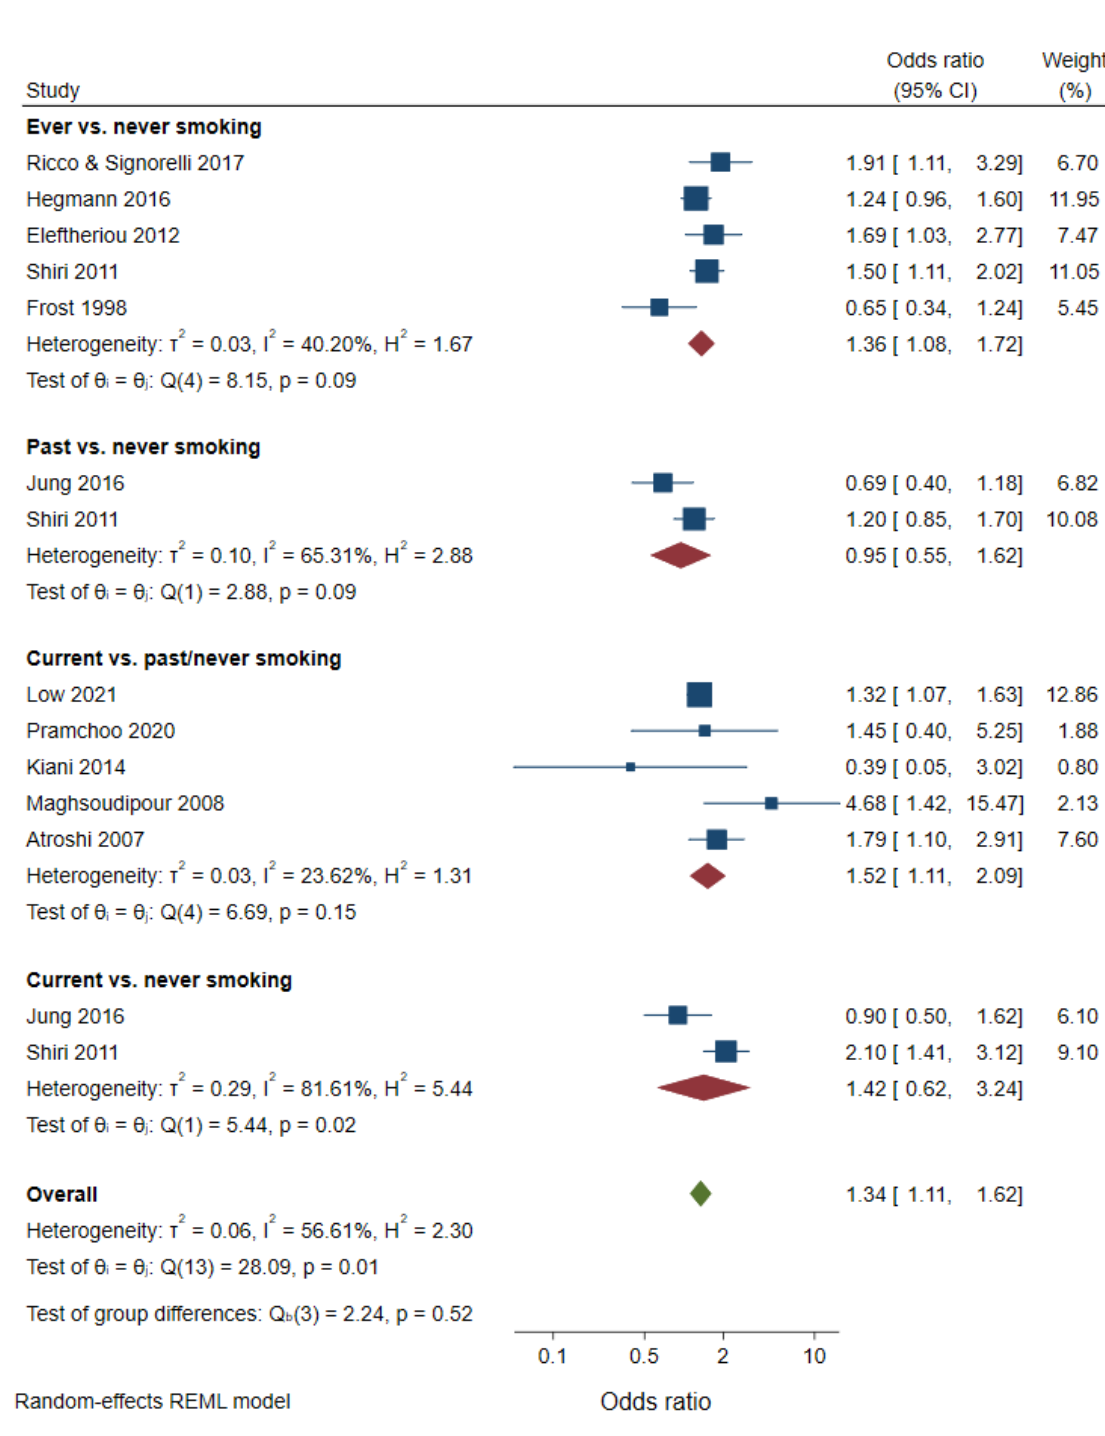
Figure 2. Meta-analysis of cross-sectional studies on smoking and CTS.